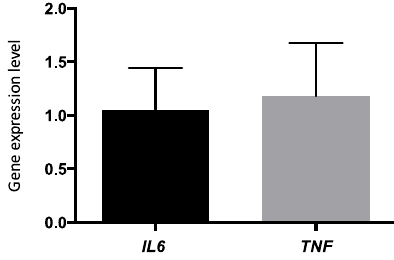
Figure 2. IL6 and TNF - α gene expressions after a 6-week n -3 FA supplementation ( n = 191). All selected SNPs were in HWE and LD plots from Haploview v4.2 for each gene are presented in Figure 3. For SNPs within the TNF - LTA gene cluster, 6 SNPS covered 93% of the known genetic variability, for IL6 , 5 SNPS covered 100%, for IL-1 β , 5 SNPs covered 100%, and for CRP , 4 SNPs covered 100%. Table 4 reports all the selected SNPs within the five inflammation-related genes studied.